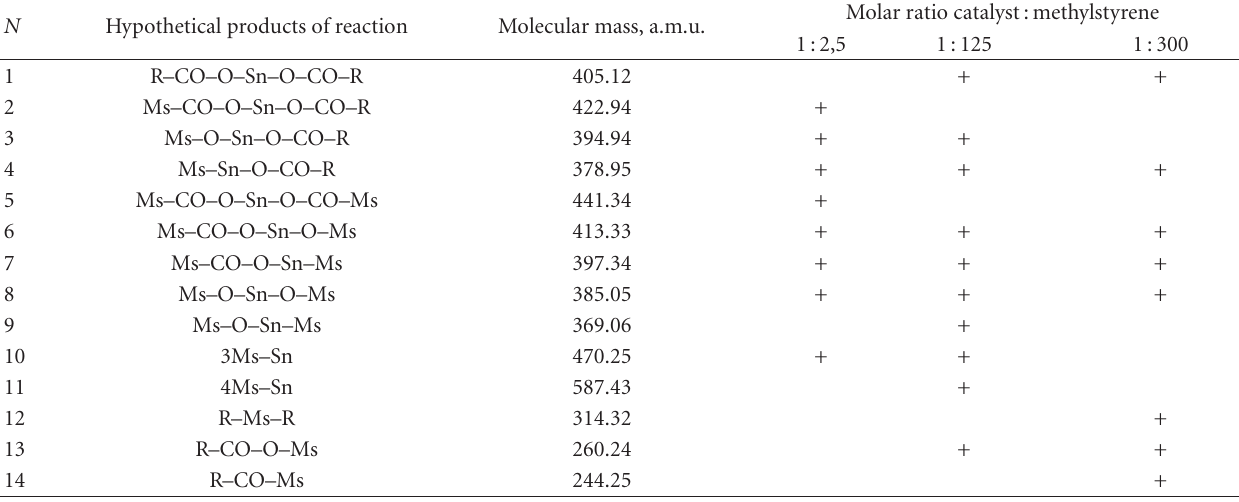
Table 4: Presence of hypothetical products of reaction between tin octoate and α -methylstyrene detected at di ff erent catalyst : α -methyl- styrene